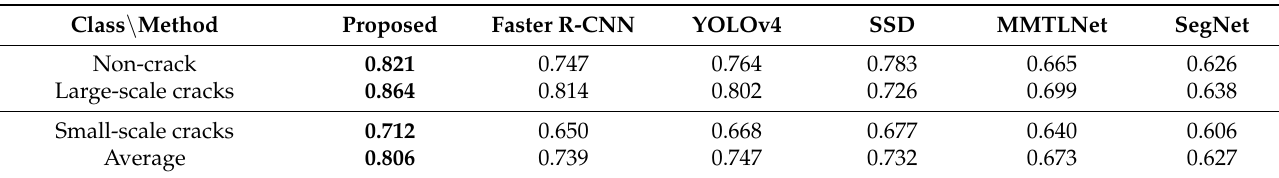
Table 4. Algorithms comparison in crack detection accuracy.